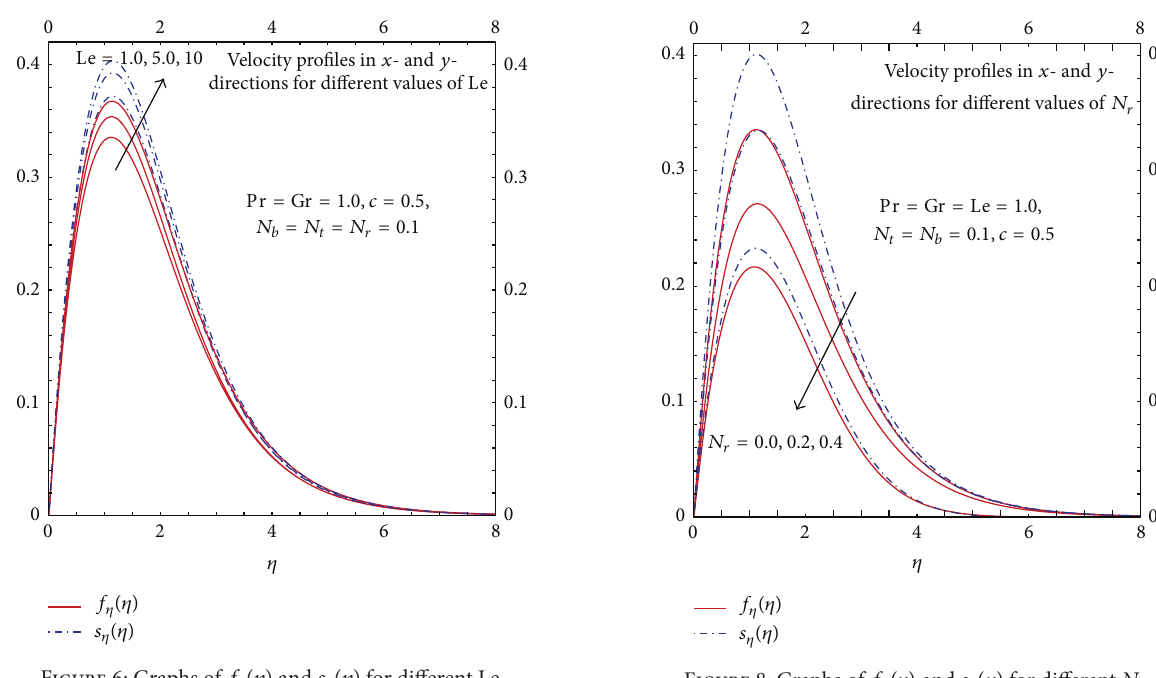
Figure 8: Graphs of 𝑓 𝜂 (𝜂) and 𝑠 𝜂 (𝜂) for different 𝑁 𝑟 .